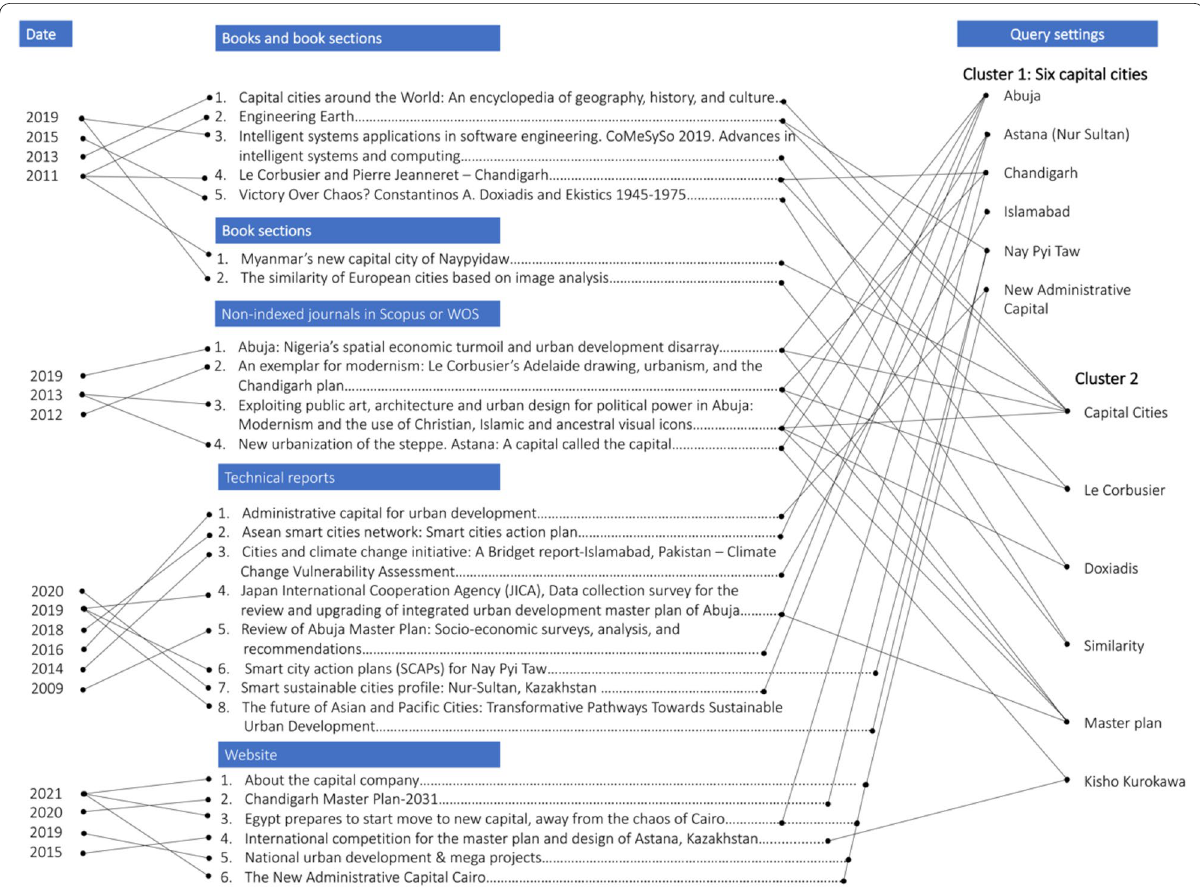
Fig. 4 Query settings in books, book sections, non-indexed journals, technical reports and websites in the last two